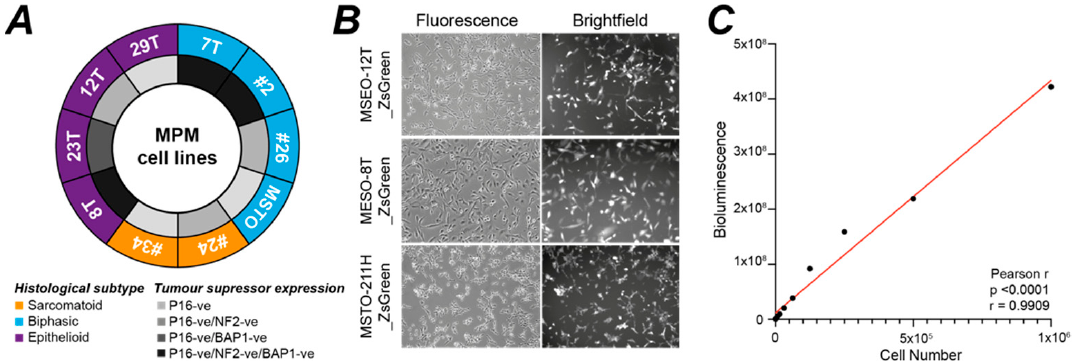
Figure 1. Characteristics of MPM cell lines used for engraftment. ( A ) Summary of the ten MPM cell lines used in this study. Histological sub-type was defined by the supplying cell bank, tumour suppressor status was inferred from immunoblotting [48]; ( B ) MPM cell lines were transduced with lentiviral particles carrying pHIV-Luc-ZsGreen. Example fluorescence images of MESO-12T, MESO-8T and MSTO-211H cells grown in vitro show high efficiency of transduction ( n = 1), other cell lines in Figure S1A; ( C ) Example in vitro analysis of luminescence signal shows proportionality with cell number for the MESO-8T cell line ( n = 1), supporting kinetics data in Figure S1B.